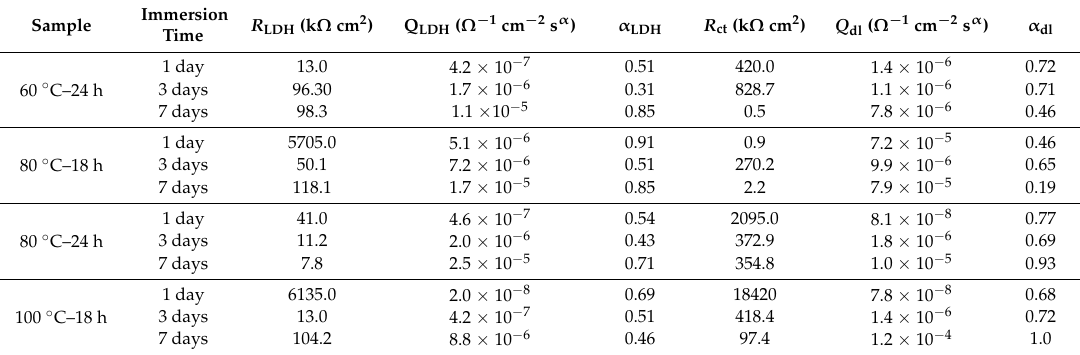
Table 4. Evolution with time of the fitting parameters R LDH , Q LDH , α LDH , R ct , Q dl, and α dl . Sample